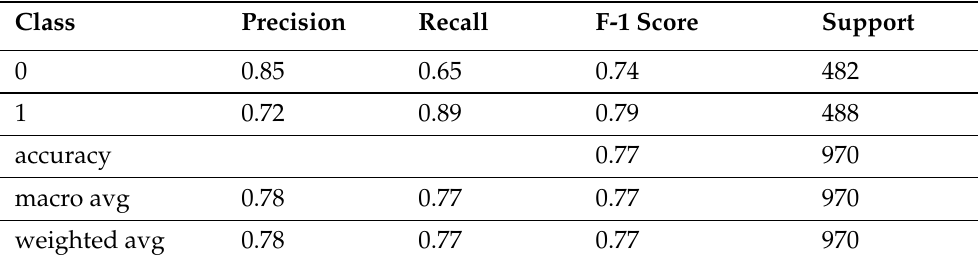
Table 8. Classification report for TF-IDF with